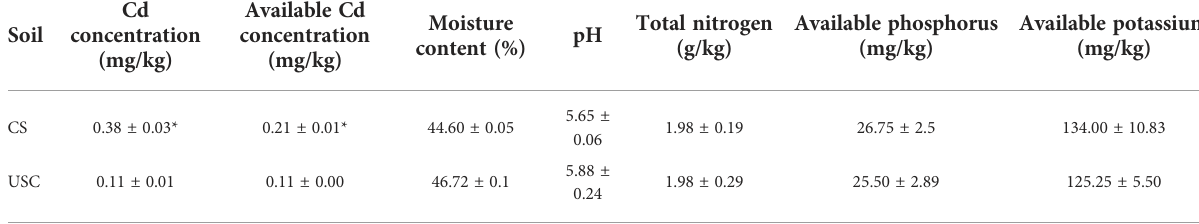
TABLE 1 Cd concentrations and physicochemical properties of tested